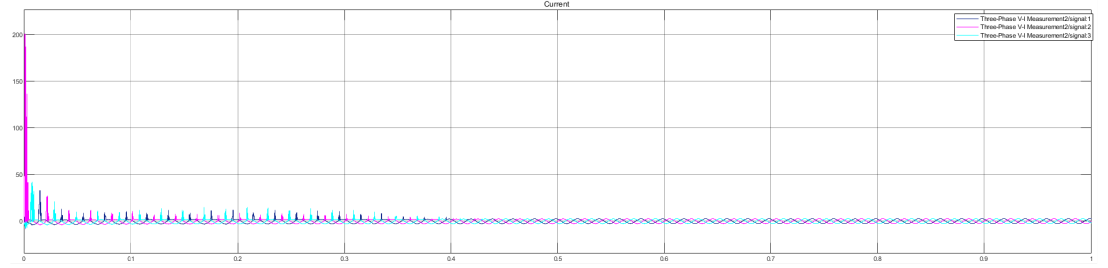
Figure 17. Simulation of current output of the selected wind turbine.